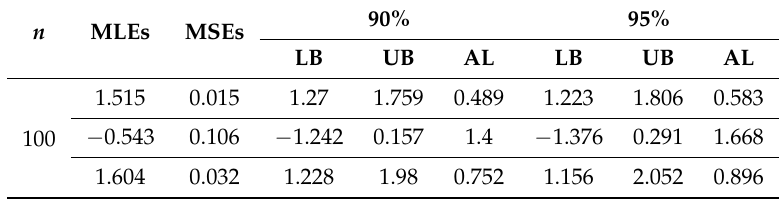
Table 4. Numerical measures of interest of the TOFrE model for Set2 (1.5, − 0.3, 1.5).